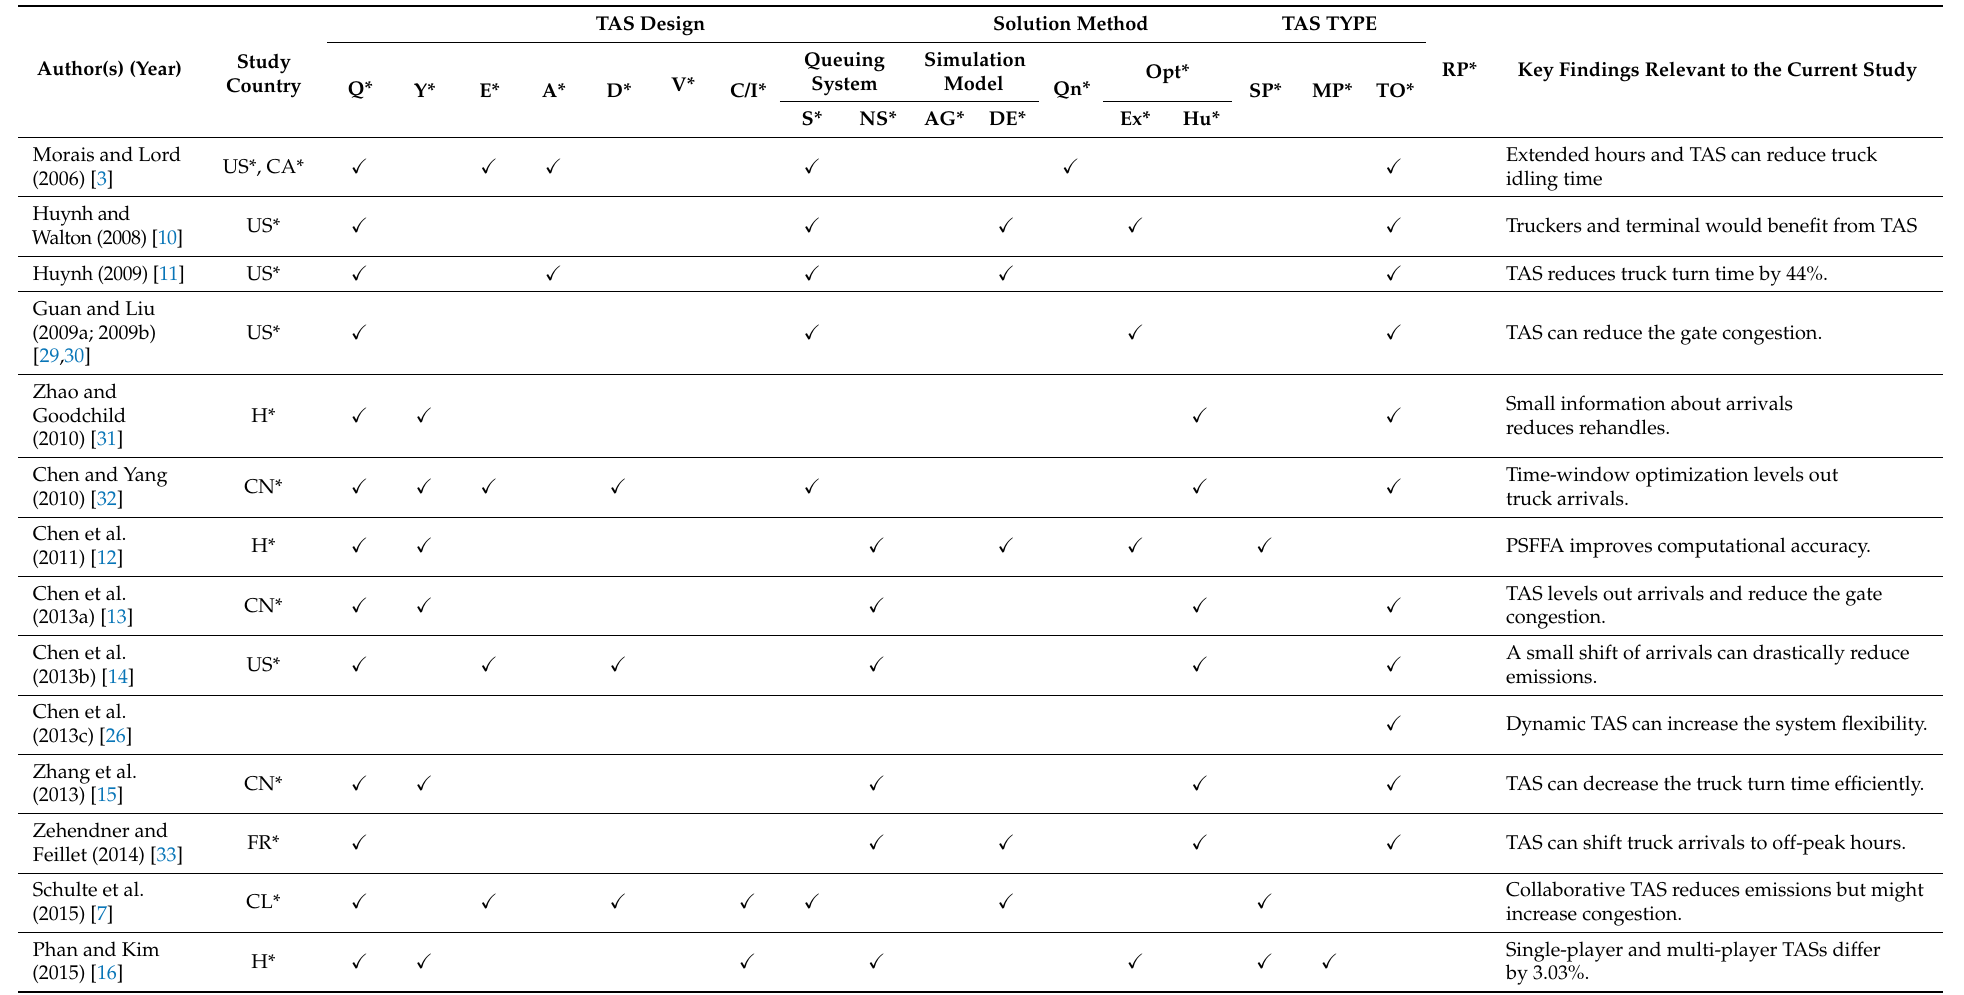
Table 1. Summary of the TAS literature